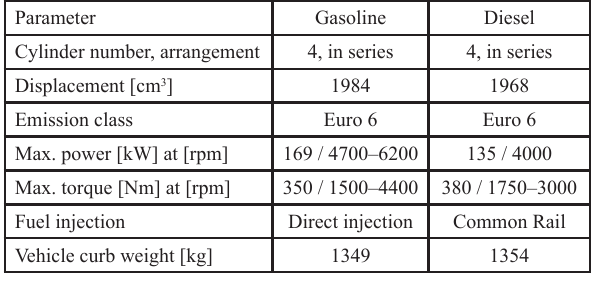
Table 1. Characteristics of engine/vehicle used in testing